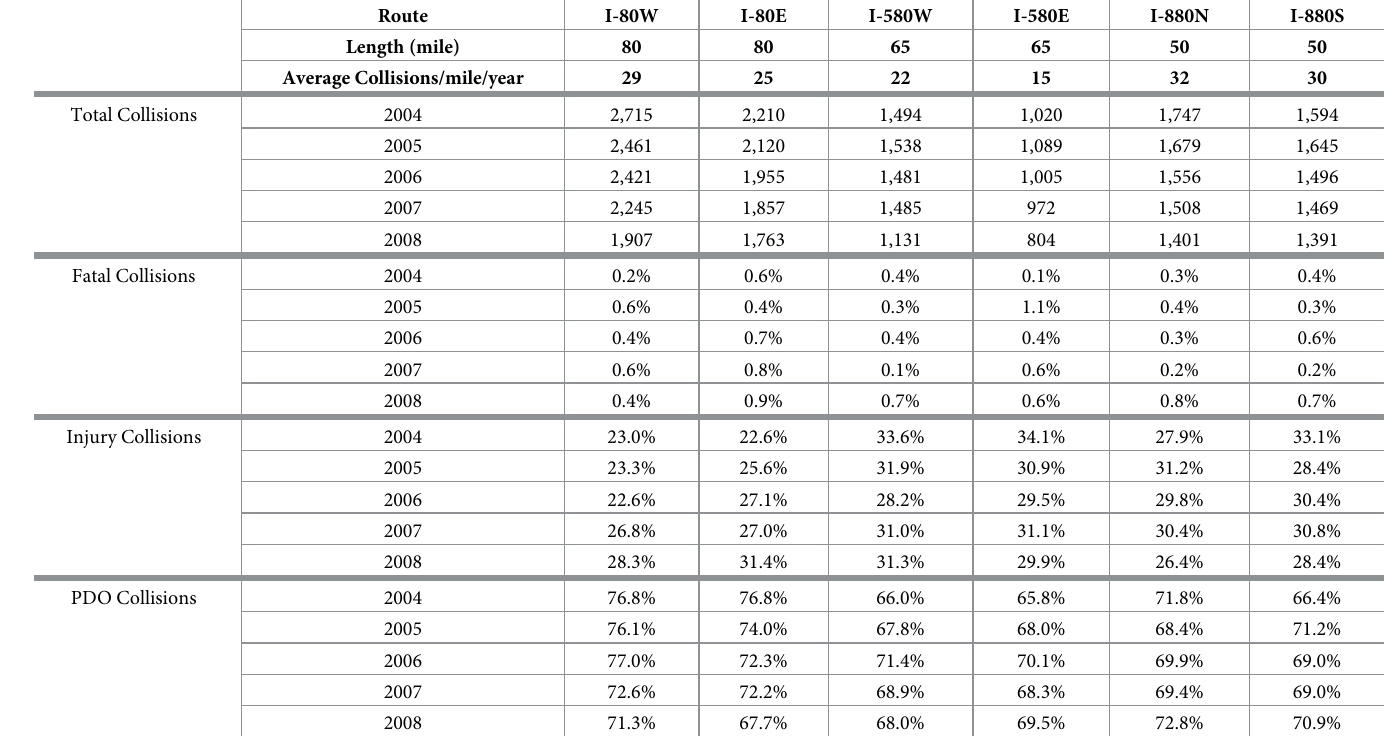
Table 1. Total number of collisions for each route by collision severity and year.